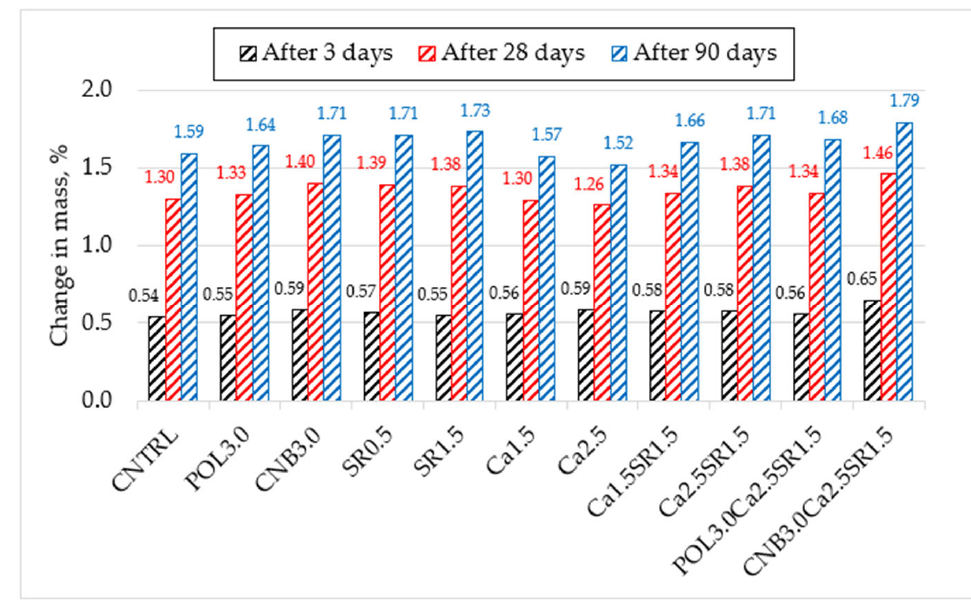
Figure 10. The changes in mass of concrete after 3, 28, and 90 days. Test results showed that after 90 days of hardening, neither concrete composition lost more than 2% of the weight. The change in mass of the reference specimens after 9 days was 1.59%. The highest change in the weight of concrete was observed in the first days; as much as 34.0% of the total weight loss occurred during the first 3 days, and as much as 81.8% after 28 days of hardening. It is assumed that in the first days, the highest amount of free water evaporates from the concrete structure, resulting in the largest changes in the mass of the concrete. 28 days, it was decided to graph the relationship between these indicators. In the graph (Figure 11), all compositions of concrete mixes are arranged in descending order of shrink- age after 28